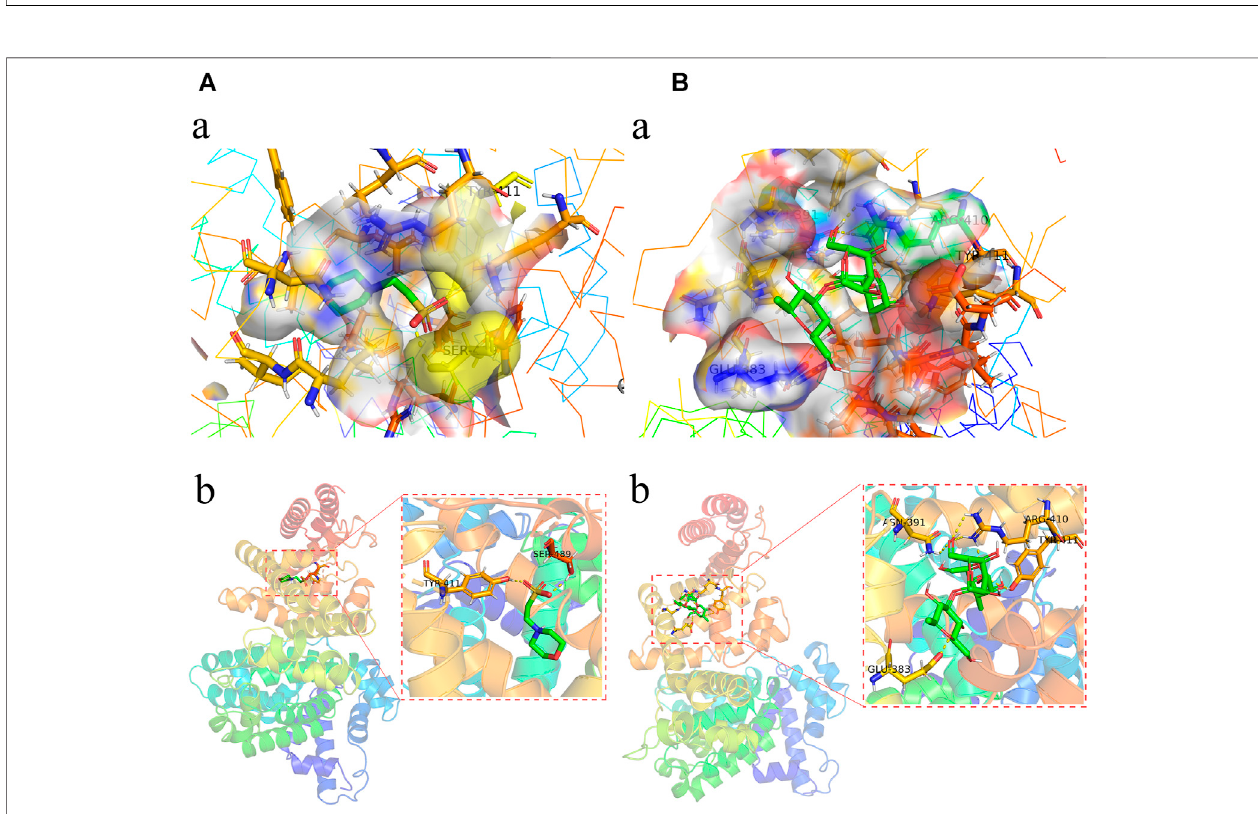
FIGURE 6 | The molecular docking analysis shows potent binding activities of Pachyman with 6QIO in ALB as a crucial target in HCC.